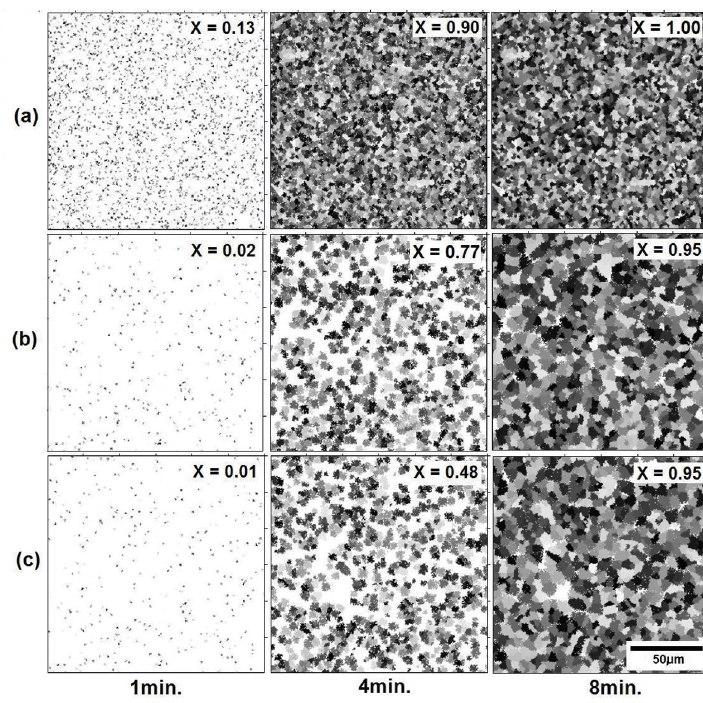
Figure 2: Evolution of primary recrystallization at 948 K for the instants 1, 4 and 8 minutes, simulated by the nucleation mechanisms of: site saturation (a), constant rate (independent of annealing temperature) (b) and treatment temperature-dependent rate